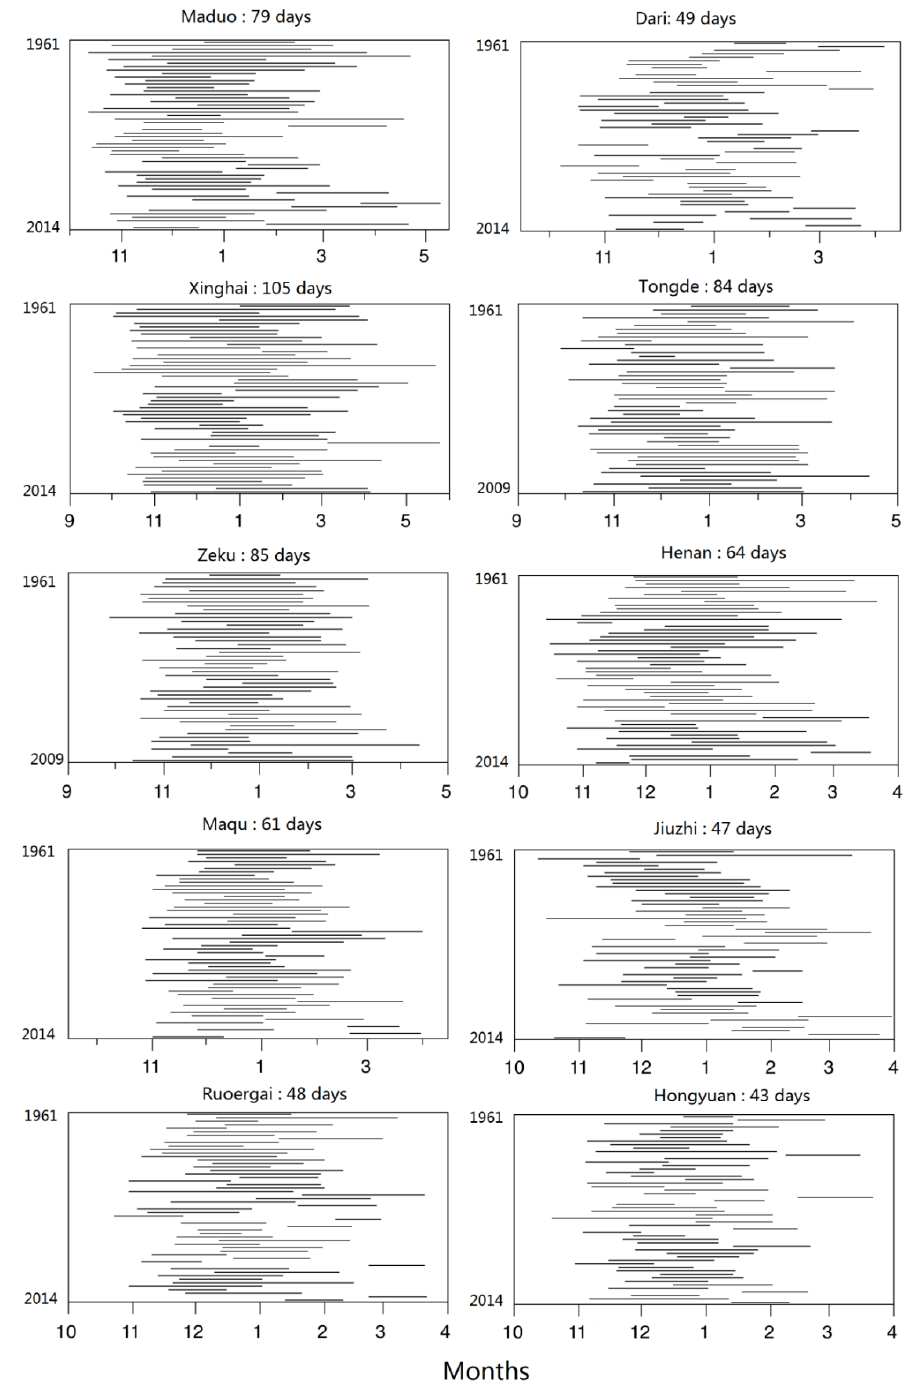
Figure 3. CDD distribution at selected locations.